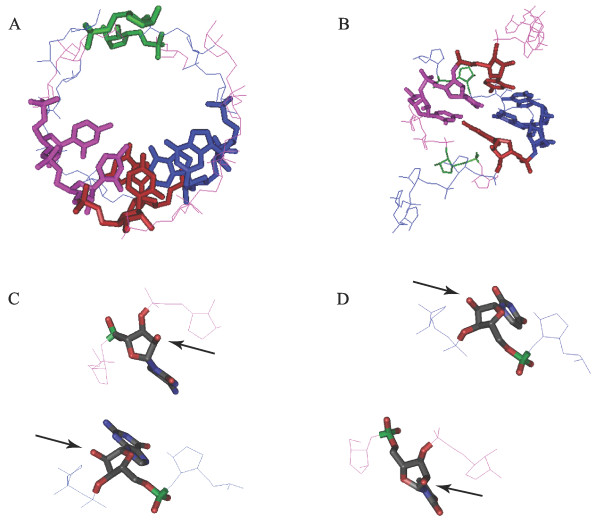
Structural features of a double stranded RNA mini-helix of 11 nucleotides. The backbones of each chain are shown in blue and pink wire representations. Their anticodons are shown in tubes; showing also the bases. The putative attachment points of the amino acids are shown in red (at the third base of the anticodon position) and green (three bases before the anticodon). (A) Top view. (B) Side view. (C,D) Close-up showing the spatial proximity of the attachment nucleotides (shown in tube representation, colour code according to atoms), and its neighbours (wire representation). The putative atoms of attachment (2'COH) of the ribose, indicated by arrows, project outside the molecule. The molecule was modeled from a known crystal structure [69, PDB ID:353D].